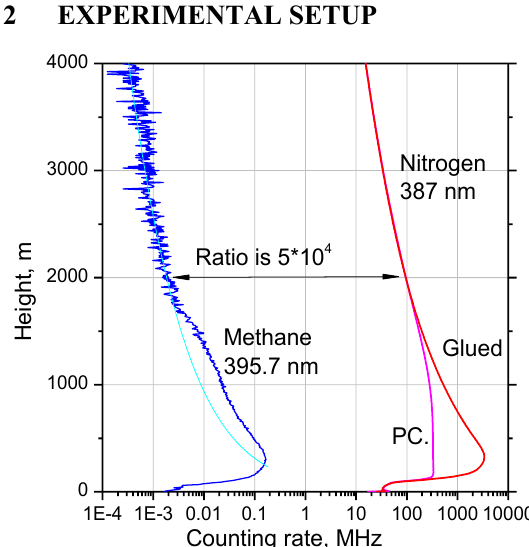
Figure 1. Raman signals corresponding to nitrogen (386.7 nm) and methane (395.7 nm) Raman scattering measured in June 2018. Signals accumulation time is 4 hours. Cian line corresponds to molecule scattering. In nitrogen channel the analog and photon count (PC) signals are